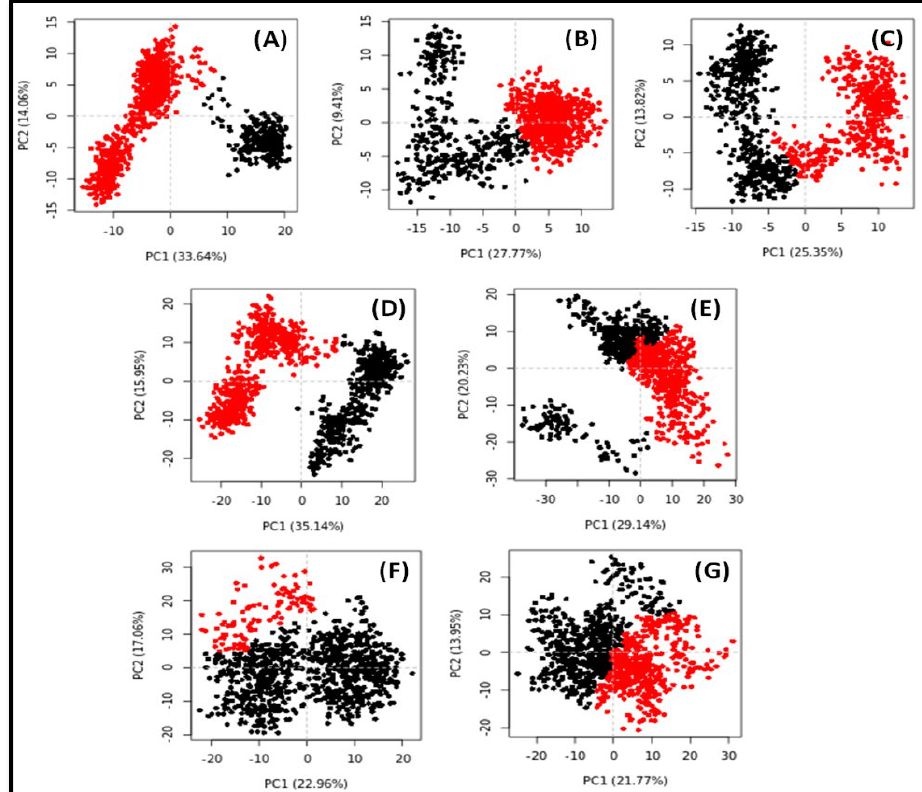
Figure 13. Principal component analysis (PCA) of PPAR- γ , 5-HT 1A , and 5-HT 2A in the absence and presence of their respective ligands. ( A ) PPAR- γ alone; ( B ) PPAR- γ in the presence of compound 1 ; ( C ) PPAR- γ in the presence of compound 3 ; ( D ) 5-HT 1A alone; ( E ) 5-HT 1A in the presence of compound 8 ; ( F ) 5-HT 2A alone; and ( G ) 5-HT 2A in the presence of compound 8.